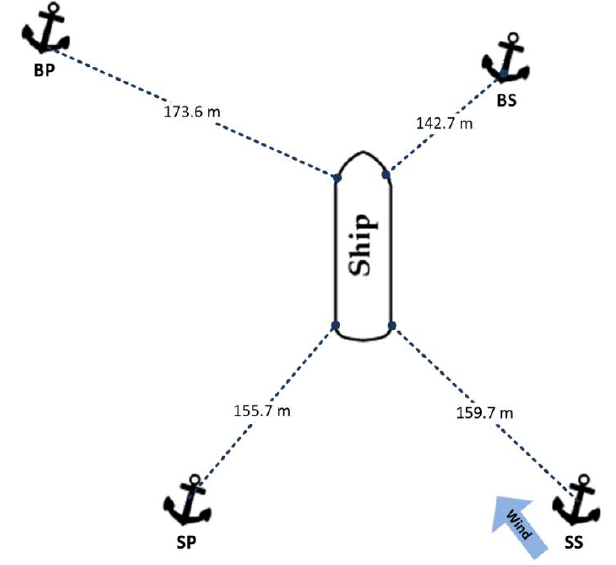
Figure 11. Anchor arrangement and vessel position during positioning.